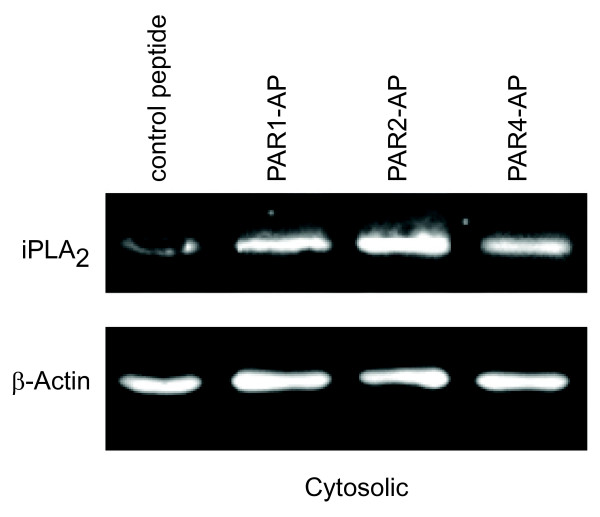
PAR-APs induce up-regulation of iPLA2 in the mouse urinary bladder. Cytoplasmic extract from the bladder mucosa of wild type mice instilled with PAR-APs- or control peptide were subjected to Western Blot analysis to measure relative concentration of iPLA2. Results are representative of four separate experiments.